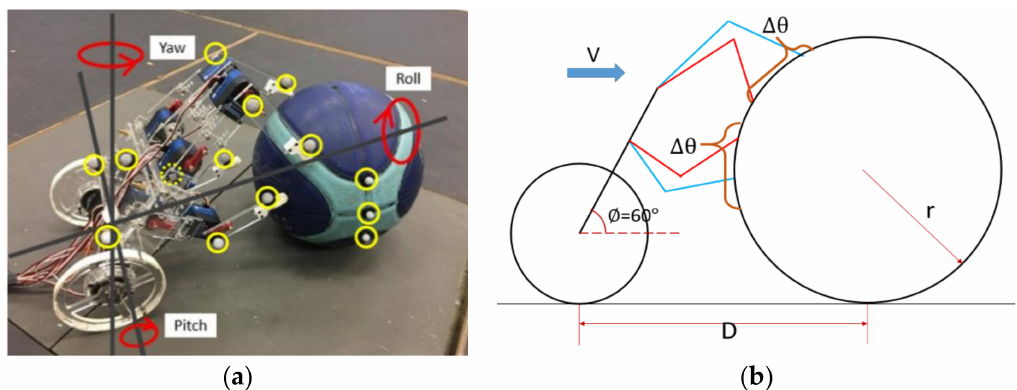
Figure 11. ( a ) Markers (yellow circle) were installed on the robot and the ball to collect quantitative motion data, and ( b ) parameters of the robot in ball rolling motion.